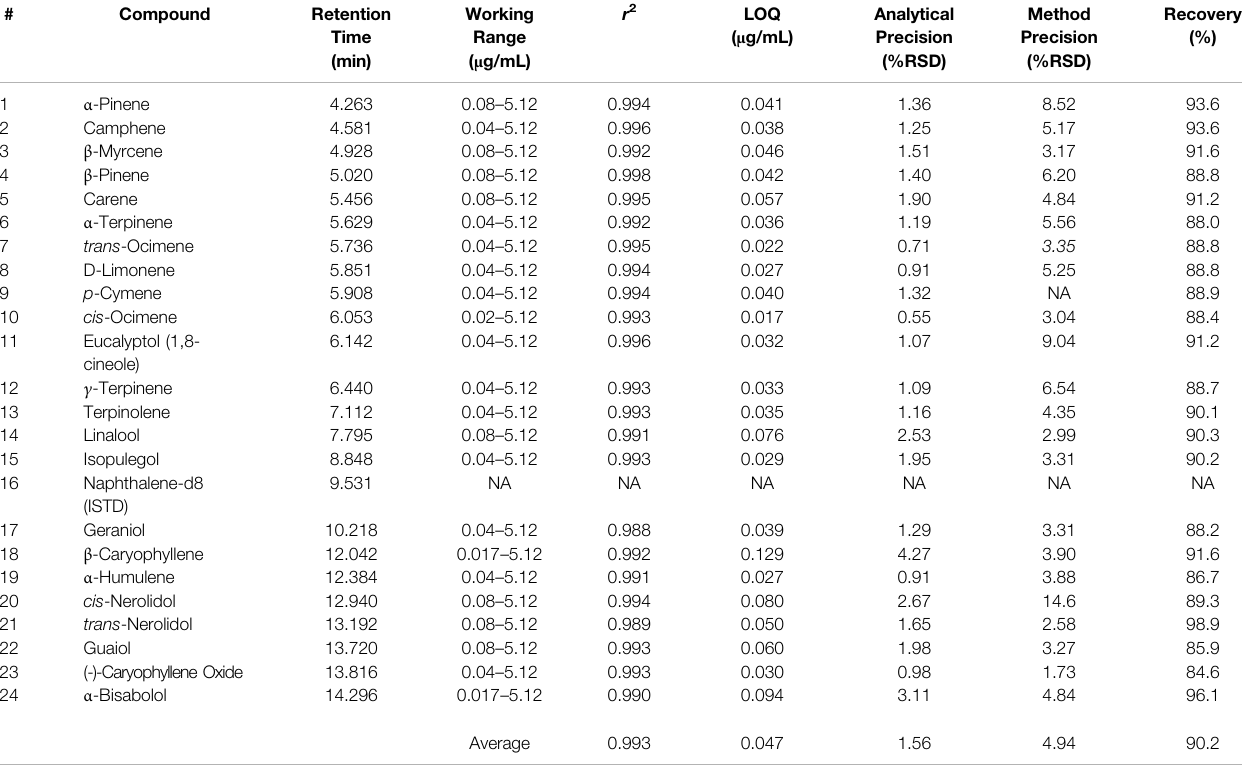
TABLE 6 | LI-Syringe – GC-MS method validation with ASE extracted cleaned hops matrix for